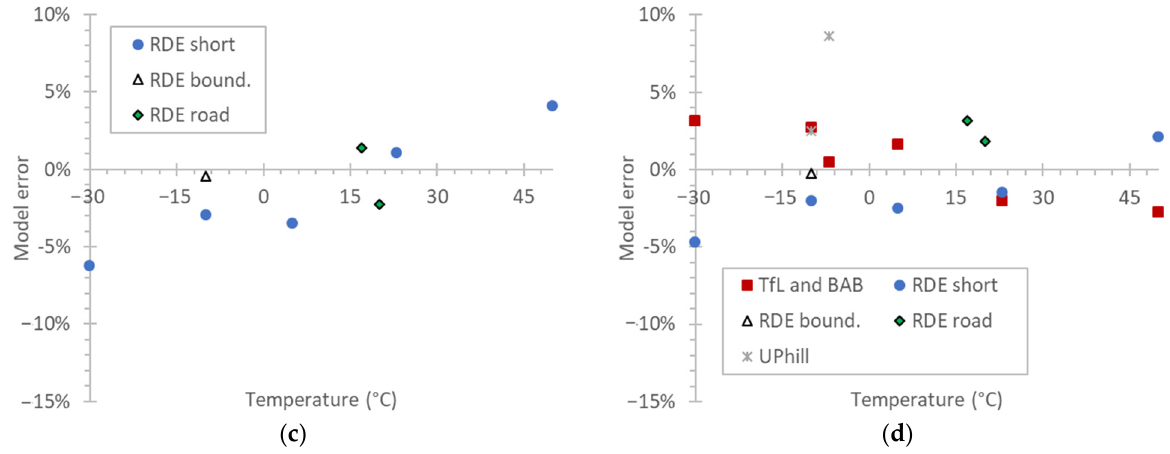
Figure A1. Model error at ( a ) urban cycles (TfL, uphill) or urban parts of other cycles, ( b ) motorway cycles (BAB) or motorway part of other cycles, ( c ) rural parts, and ( d ) complete cycle.